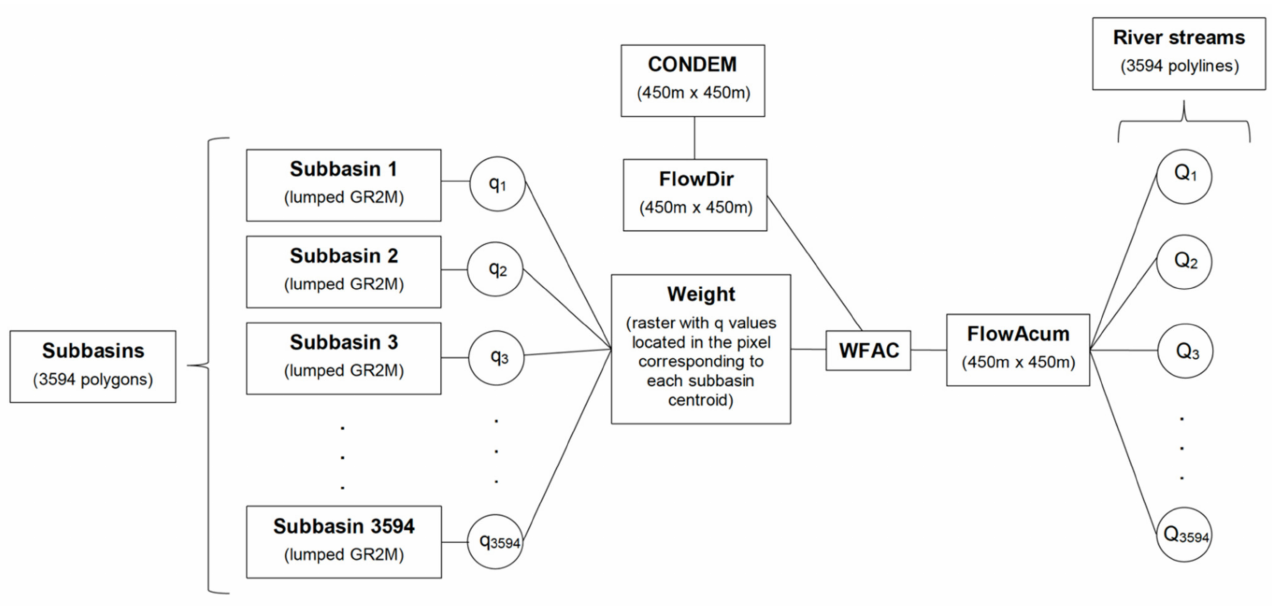
Figure 3. Framework to calculate accumulated discharges from sub-basins to river streams in a semi-distributed GR2M adaptation. Where: q = runoff in mm, CONDEM = Hydrologically Conditioned Digital Elevation model, FlowDir = Flow Direction, WFAC = Weighted Flow Accumulation, FlowAcum = Flow Accumulation, and Q = discharges in m 3